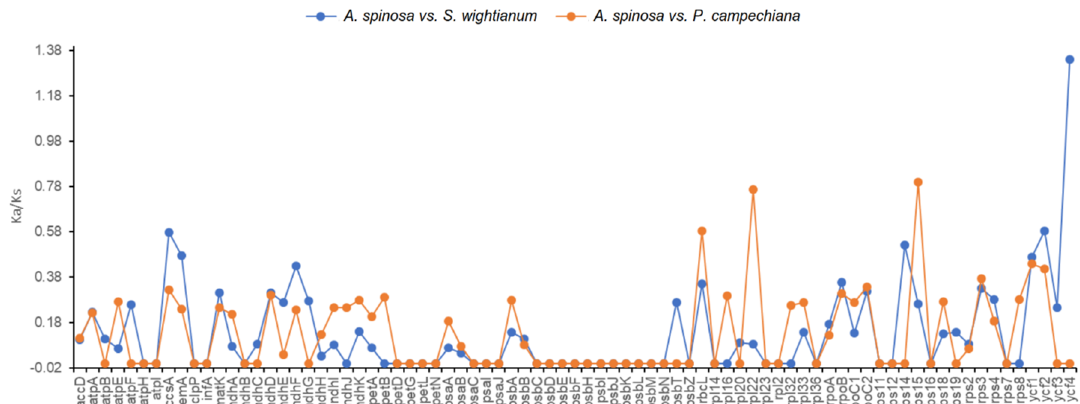
Figure 6. The Ka / Ks values of 79 protein-coding genes of the three Sapotaceae cp genomes. The calculation was performed for paired sequences of the species A. spinosa vs. S. wightinaum and A. spinosa vs. P. campechiana .